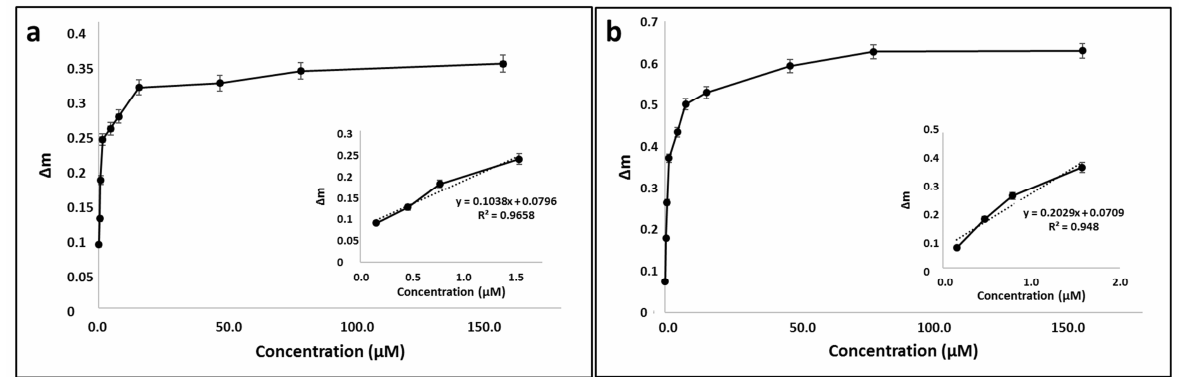
Figure 7. Effect of Cu(II) initial concentration on Cu(II)-MIP1 ( a ) and Cu(II)-MIP2 ( b ) QCM